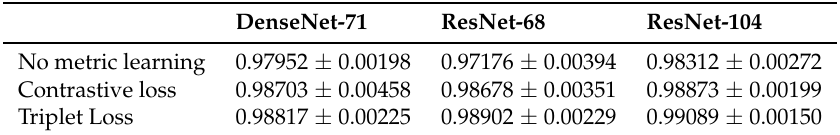
Table 2. Area under the receiver operating characteristics (ROC) curve (AUC): average ± standard deviation.